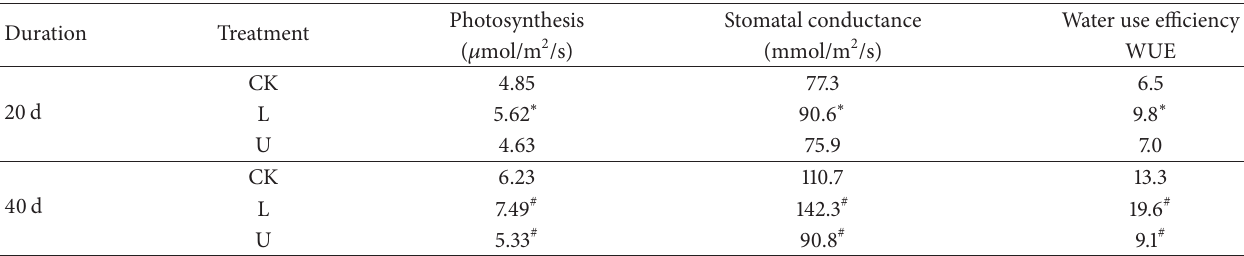
Table 3: Effects of red LEDs and UV-B on the photosynthetic characteristics of the mung bean. Photosynthesis Stomatal Duration Treatment